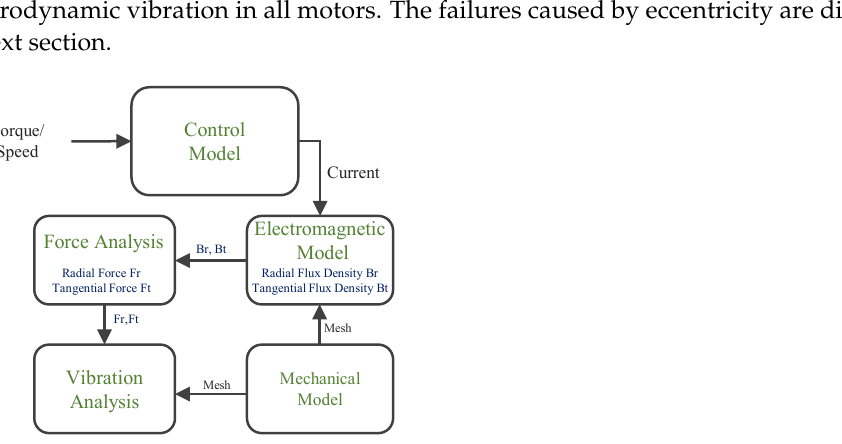
Figure 15. Flowchart of electromagnetic forces and vibration calculations with FEA